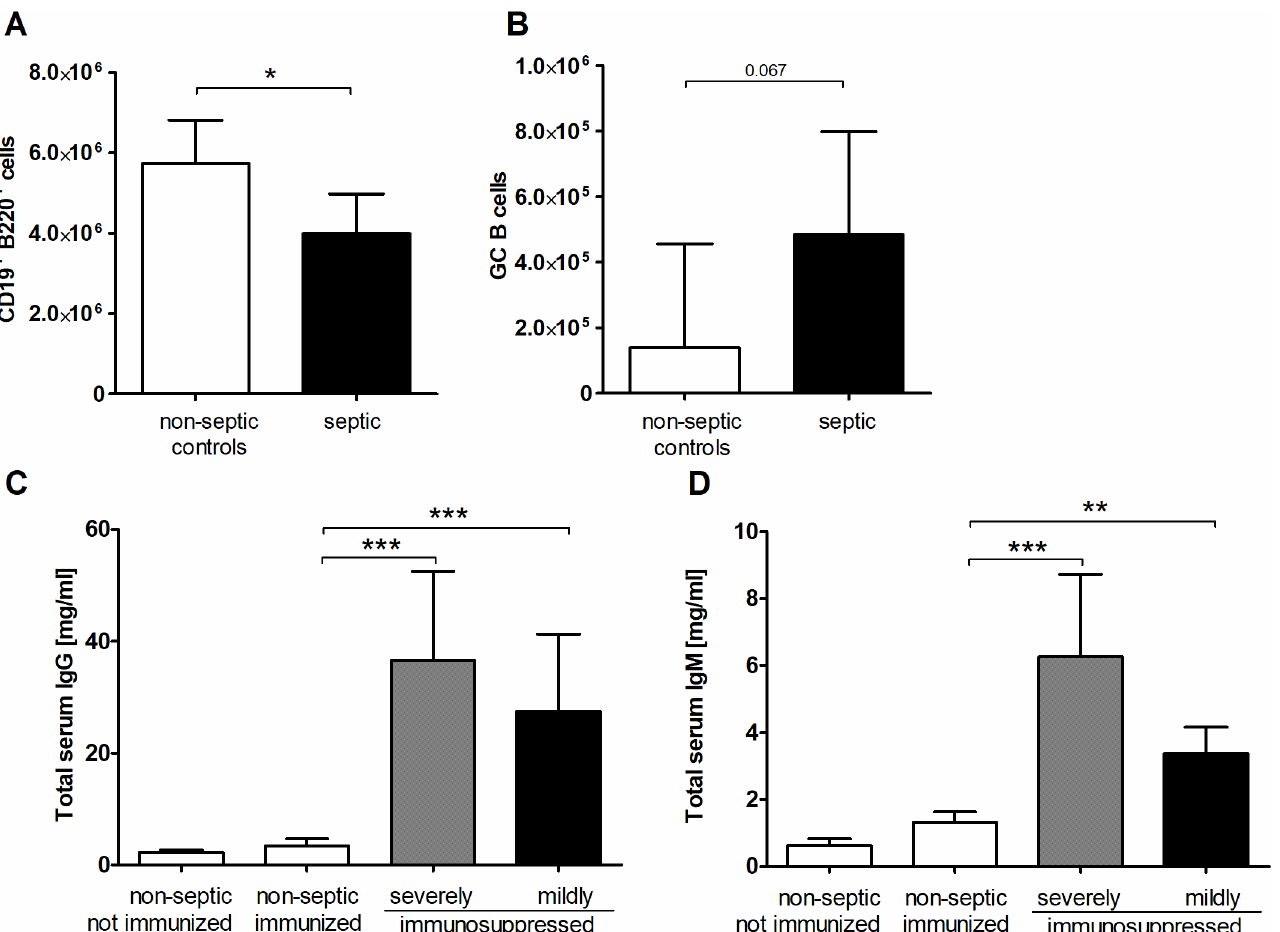
Fig 3. Sepsis elicits a strong serum antibody response. Sepsis was induced in C57BL/6 mice by AP (n = 7) and non-septic mice served as control (n = 3). After seven days, spleens were harvested and numbers of CD19 + B220 + total B cells (A) and B220 + GL7 + IgD - CD95 hi CD73 int germinal center (GC) B cells (B) were determined by flow cytometry. Gating strategies can be found as supporting information (S4 Fig). Seven days after AP mice were immunized intraperitoneally with TNP-OVA/OVA in alum, and the animals were divided into severely immunosuppressed animals (n = 15) and mildly immunosuppressed (n = 29) as depicted in Fig 1D. Non-septic, not immunized animals (n = 23) and non-septic immunized mice (n = 19) served as controls. 14 days after the test immunization, concentrations of total IgG (C) and IgM (D) in serum were measured by Luminex technology. Means and the 95% confidence interval are shown. Group differences were tested for significance with the Mann-Whitney (A, B) or the Kruskal-Wallis test and Dunn’s multiple comparison for selected pairs (C, D). Results from four separate experiments with the same tendency were combined. (cid:3)(cid:3)(cid:3) P < 0.001; (cid:3)(cid:3) P < 0.01; (cid:3) P < 0.05.